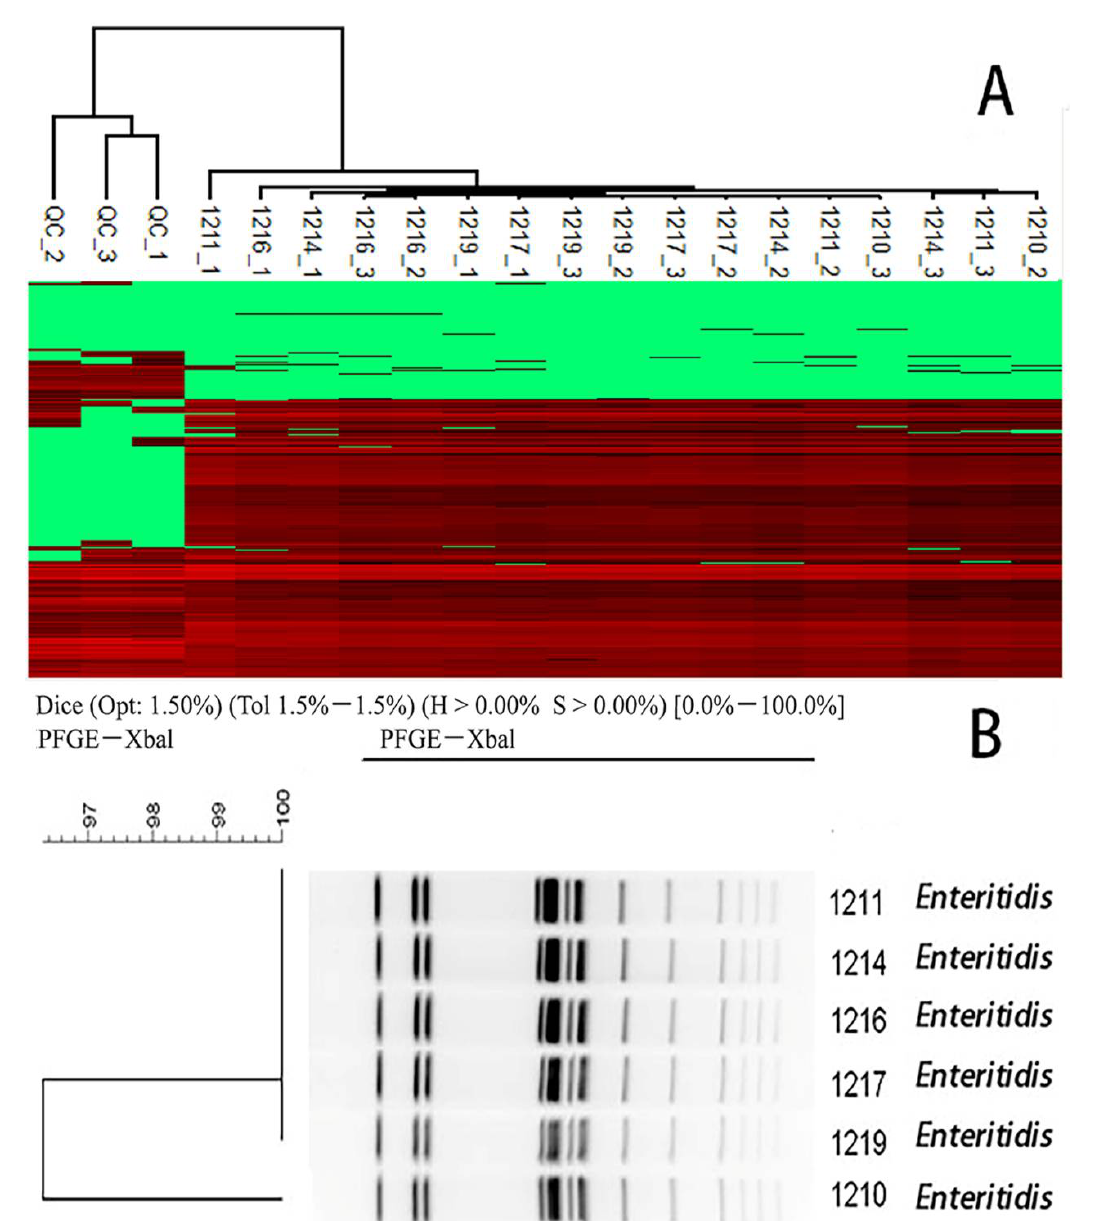
Figure 4. Hierarchical clustering to differentiate similarity among Salmonella enteric isolates. The cluster analysis by LC-MS/MS ( A ) and PFGE ( B ) in the training group. There was no evident simi- larity between Salmonella enteric strains.